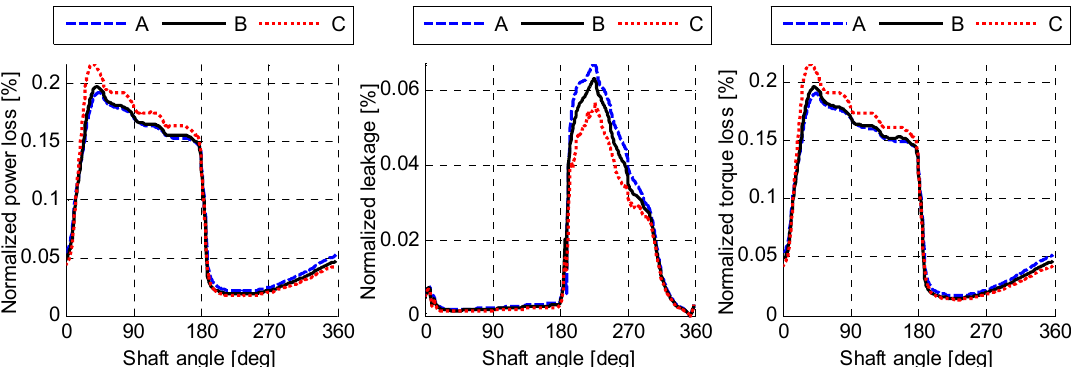
Figure 15. Normalized slipper/swashplate interface energy dissipation comparison for different sizes.